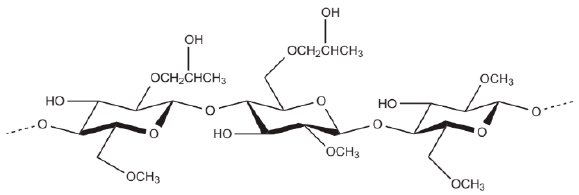
Figure 12. Chemical structure of hydroxypropyl methyl cellulose.